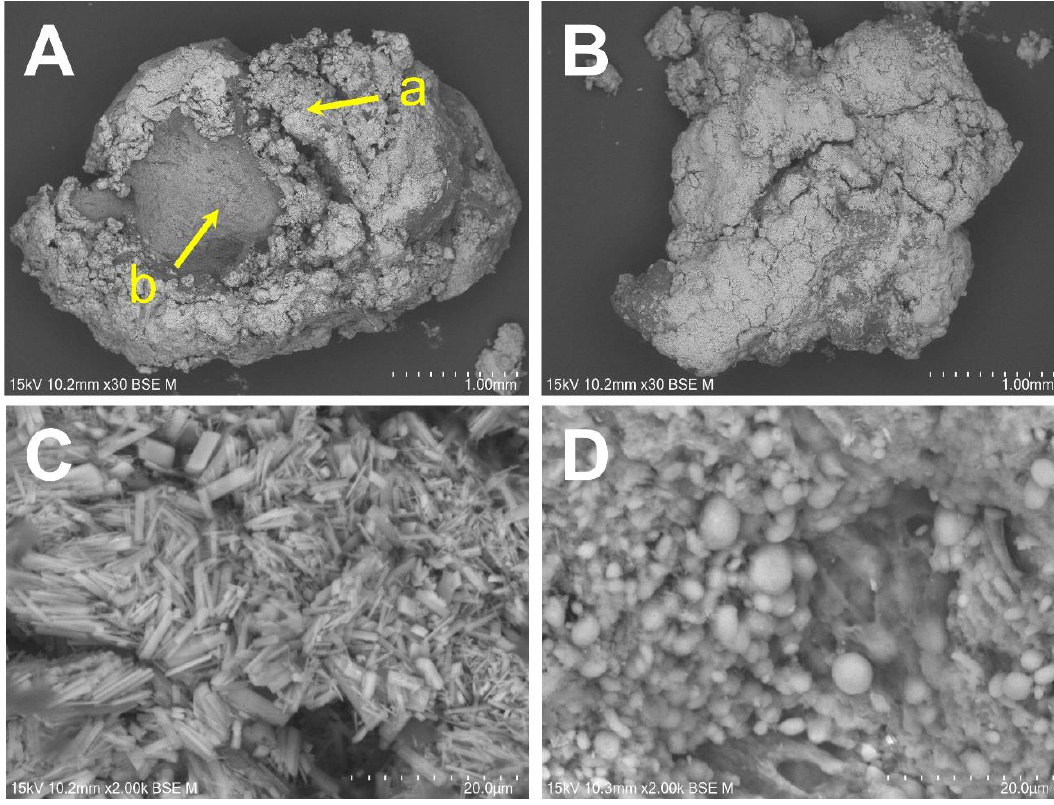
Figure 7. Scanning electronic microscopic images of the masses from the joint cavities. Masses were extracted from the ( A ) upper and ( B ) lower joint cavities (30 × ). ( C , D ) present the 2000 × high power fields of ( A-a ) and ( A-b ),